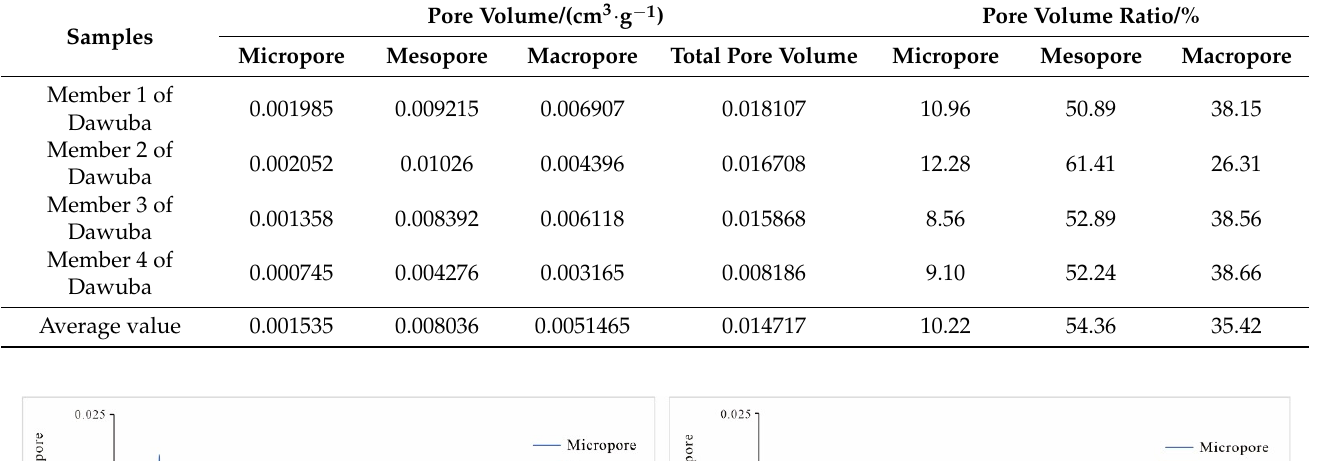
Table 2. Statistics of shale pore volume of the Dawuba Formation in the Qianxi area.